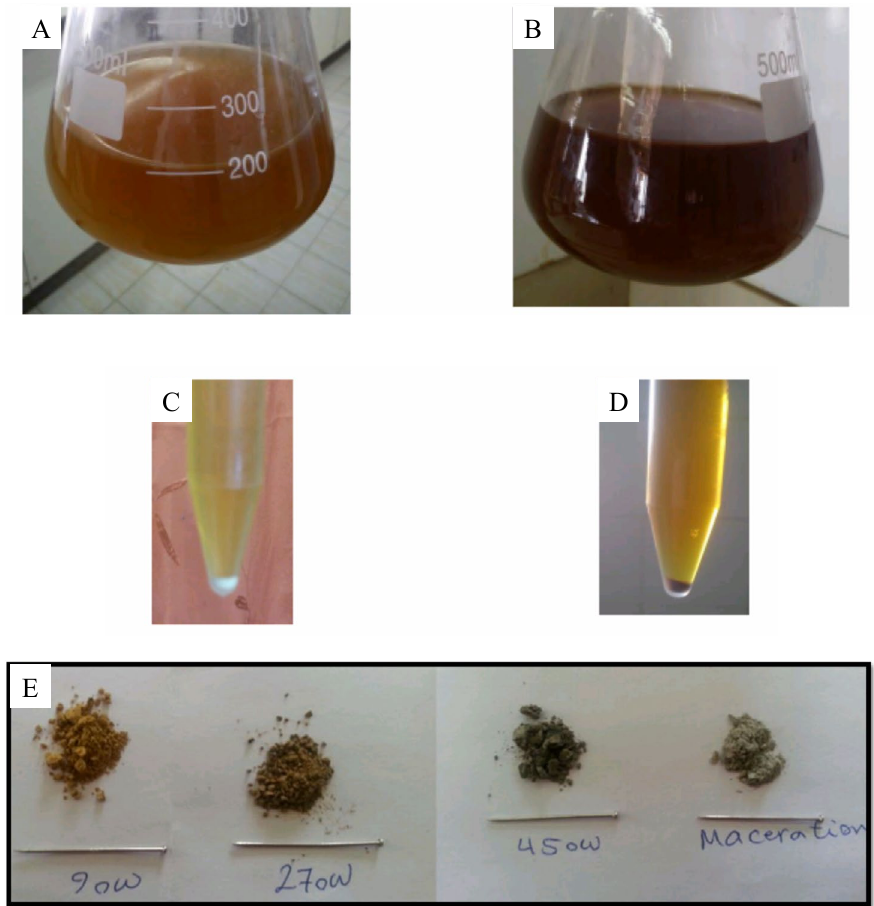
Fig. 1. Colorimetric results of the prepared Ag samples. Color of aqueous extract (A) before and (B) after addition of silver nitrate. Color of the prepared samples after (C) 10 min and (D) 1 h, and (E) image of the dried Ag samples in different synthetic conditions.